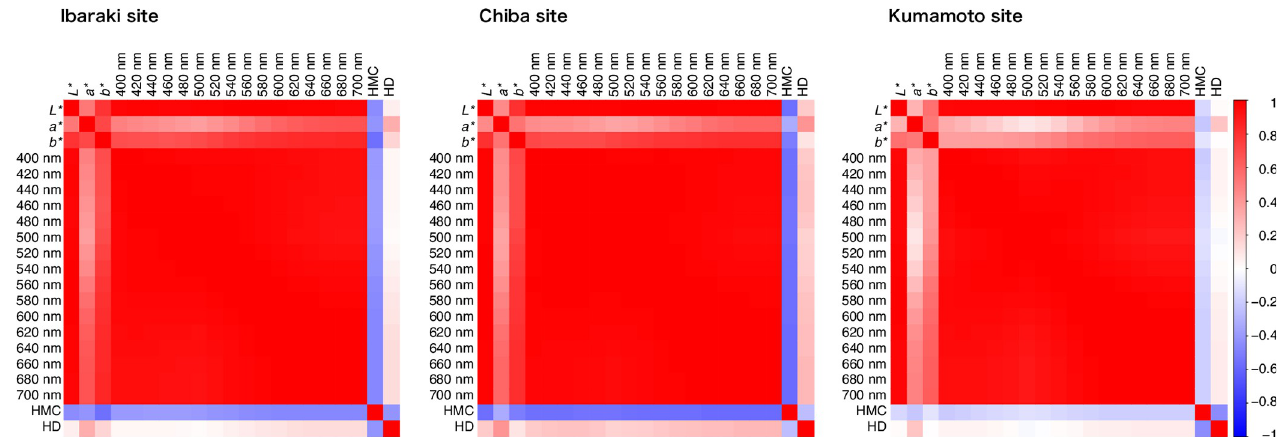
Fig 2. Correlation heatmap for heartwood color traits ( L � a � b � color space and spectral reflectance) and heartwood property traits (density and moisture